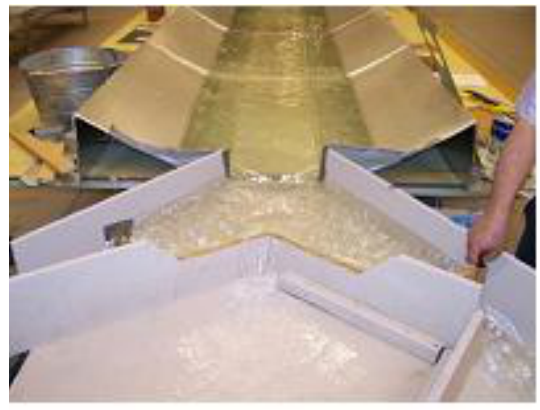
Figure 6. Picture showing the general configuration of the flume and physical model.